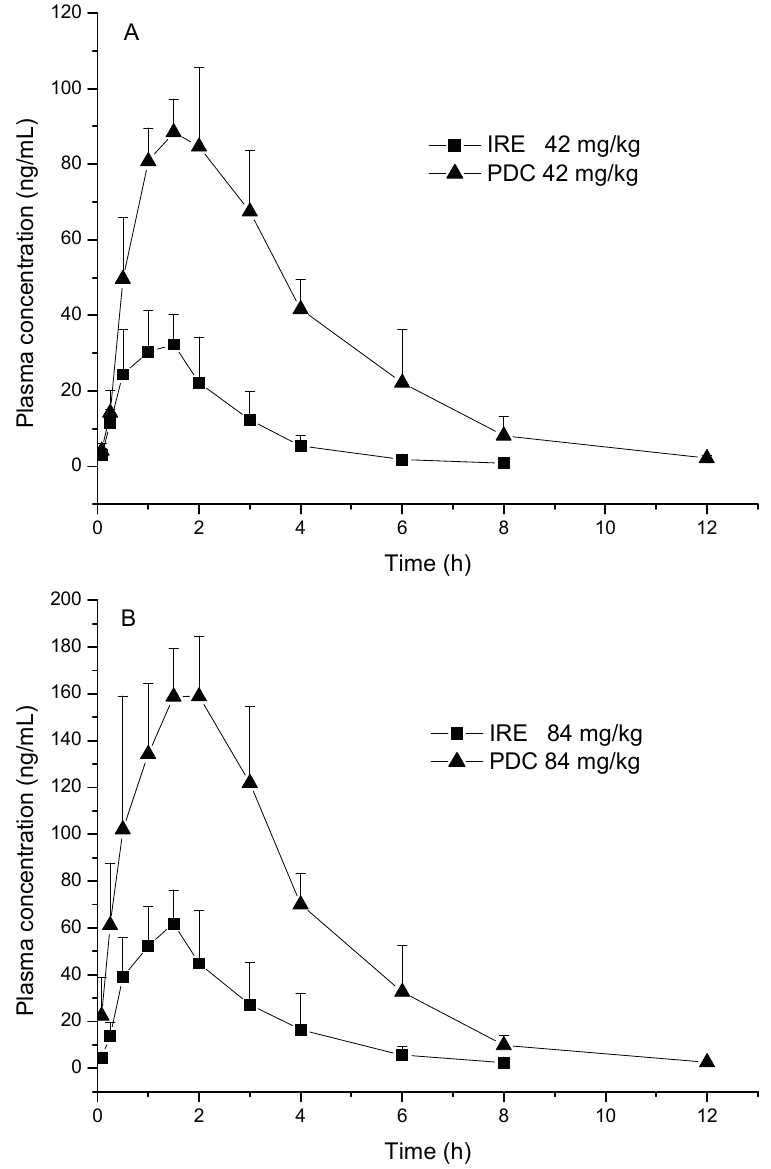
Figure 3. Mean plasma concentration-time profiles of PDC in rat plasma after oral administration of pure PDC or the IRE (dosage of IRE was equivalent to corresponding PDC dosage) ( n = 6). ( A ) plot for 42 mg/kg PDC and IRE; ( B ) plot for 84 mg/kg PDC and